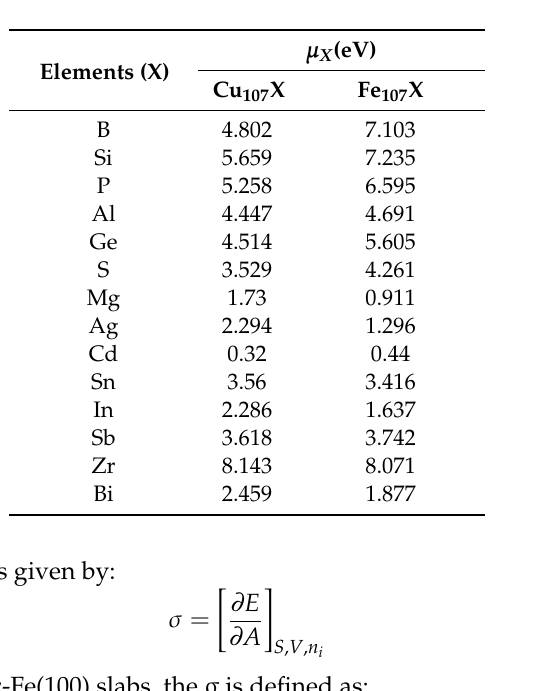
Table 2. Chemical potentials of elements (X), a dilute solid solution Cu 107 X and a dilute solid solution Fe 107